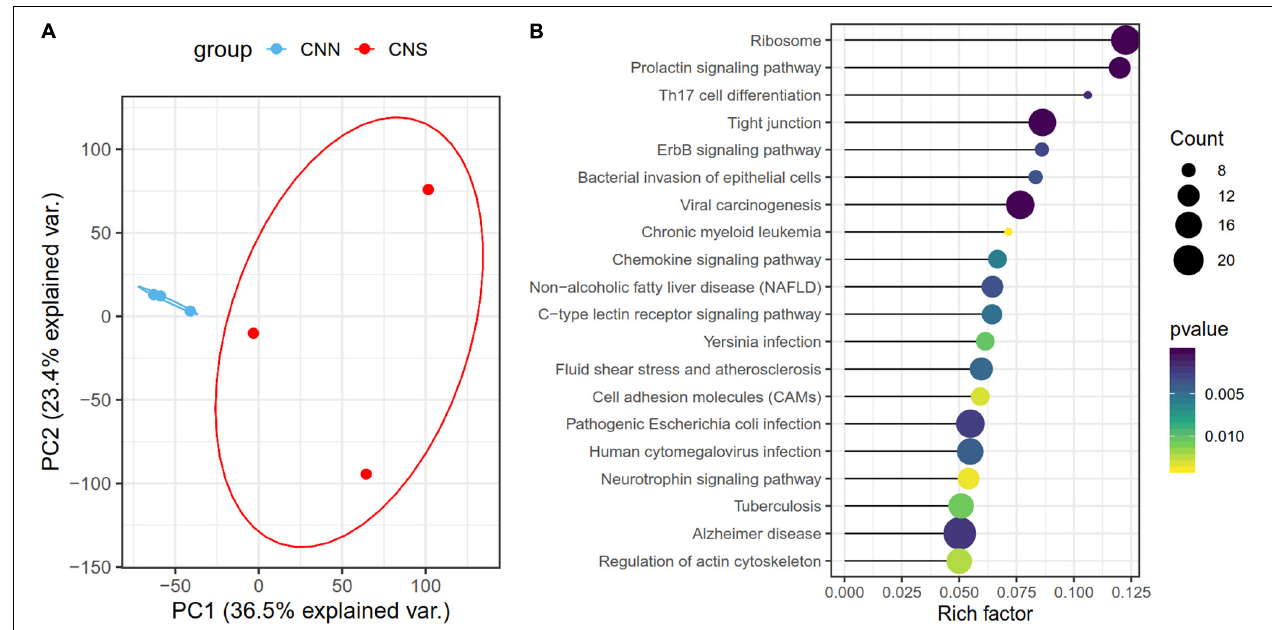
FIGURE 2 | (A) Principal component analysis (PCA) of all normalized gene expression levels (TPM) clustered by geographic distribution, demonstrating different transcriptomic patterns of H. discus hannai in the two populations. The blue scatters indicate the CNN population and the red one indicates the CNS population. (B) Scatter plot showing the top 20 enriched KEGG pathways, resulting from the top 30% contributing genes within the PC1.